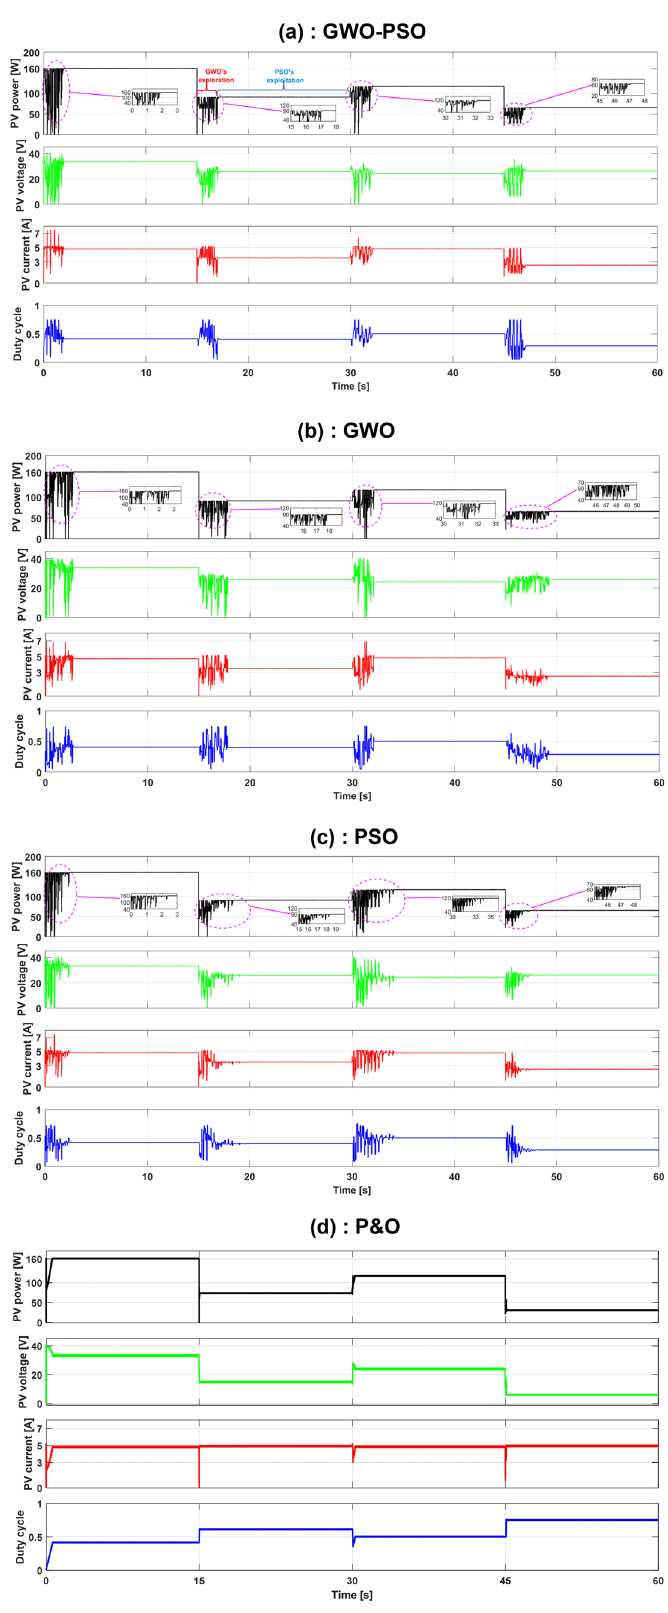
Figure 11. Obtained curves under the different shading pattern variations using: ( a ) GWO–PSO, ( b ) GWO, ( c ) PSO, ( d ) P&O based MPPT